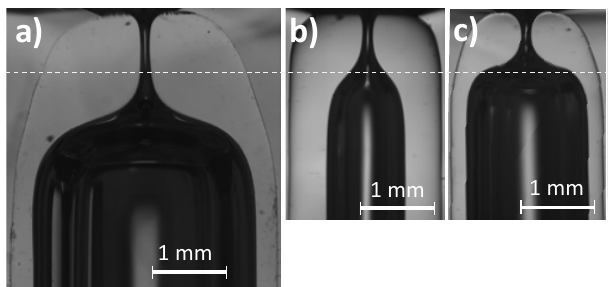
Figure 11. Nozzles of D ≈ 135 µ m manufactured from different size capillaries. ( a ) Capillary type 1, r = 5 mm, t = 600 s, ∆ L = 1.22 mm; ( b ) Capillary type 3, r = 6.6 mm, t = 480 s, ∆ L = 0.11 mm; ( c ) Capillary type 4, r = 6.6 mm, t = 480 s, ∆ L = 0.54 mm. The line is to guide the